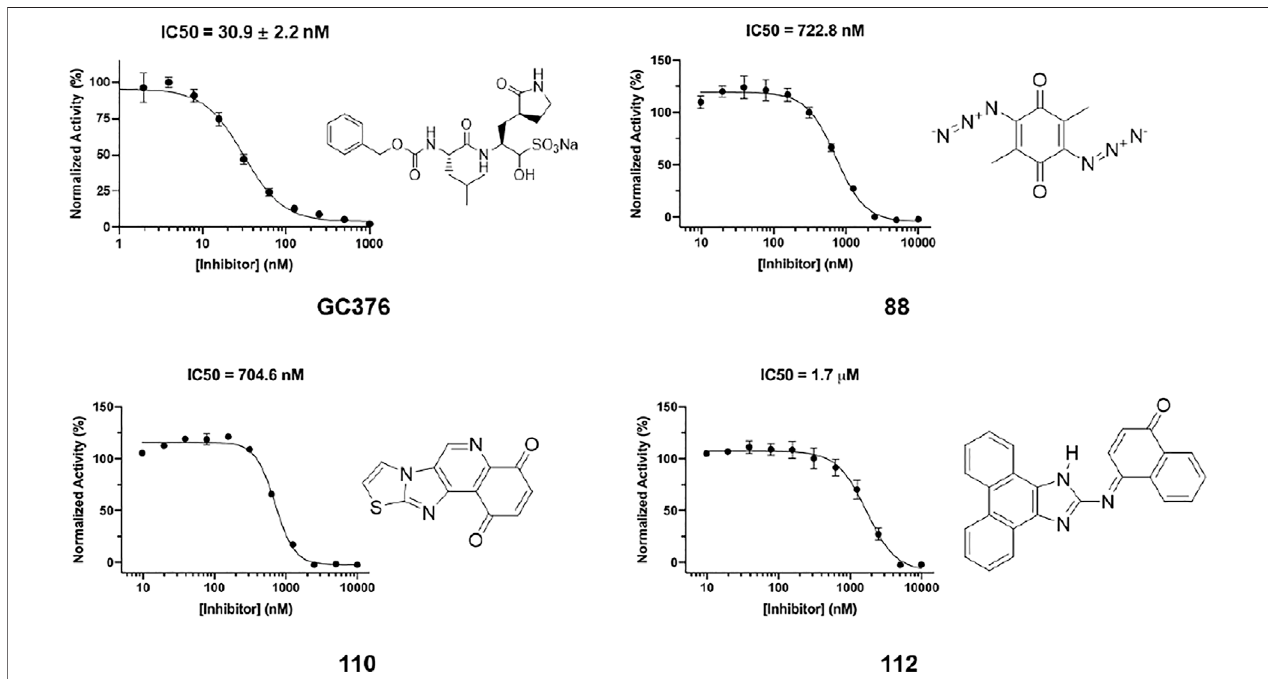
FIGURE 5 | IC 50 determination of selected compounds from the docking process against Mpro. GC376 was tested as control. Triplicate experiments were performed for each compound. GraphPad Prism 8.0 was used to perform data analysis.